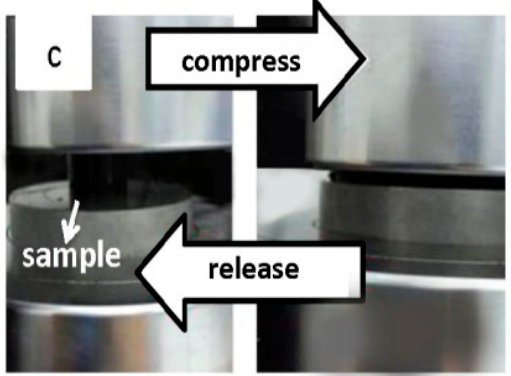
Figure 8. ( a ) Compressive stress-strain curves of ACX-gels and ACX-MNP-gels; ( b ) the elastic modulus of ACX-gels and ACX-MNP-gels with different C; ( c ) the ACX-MNP-gels were highly compressed and quickly recovered to their original state.